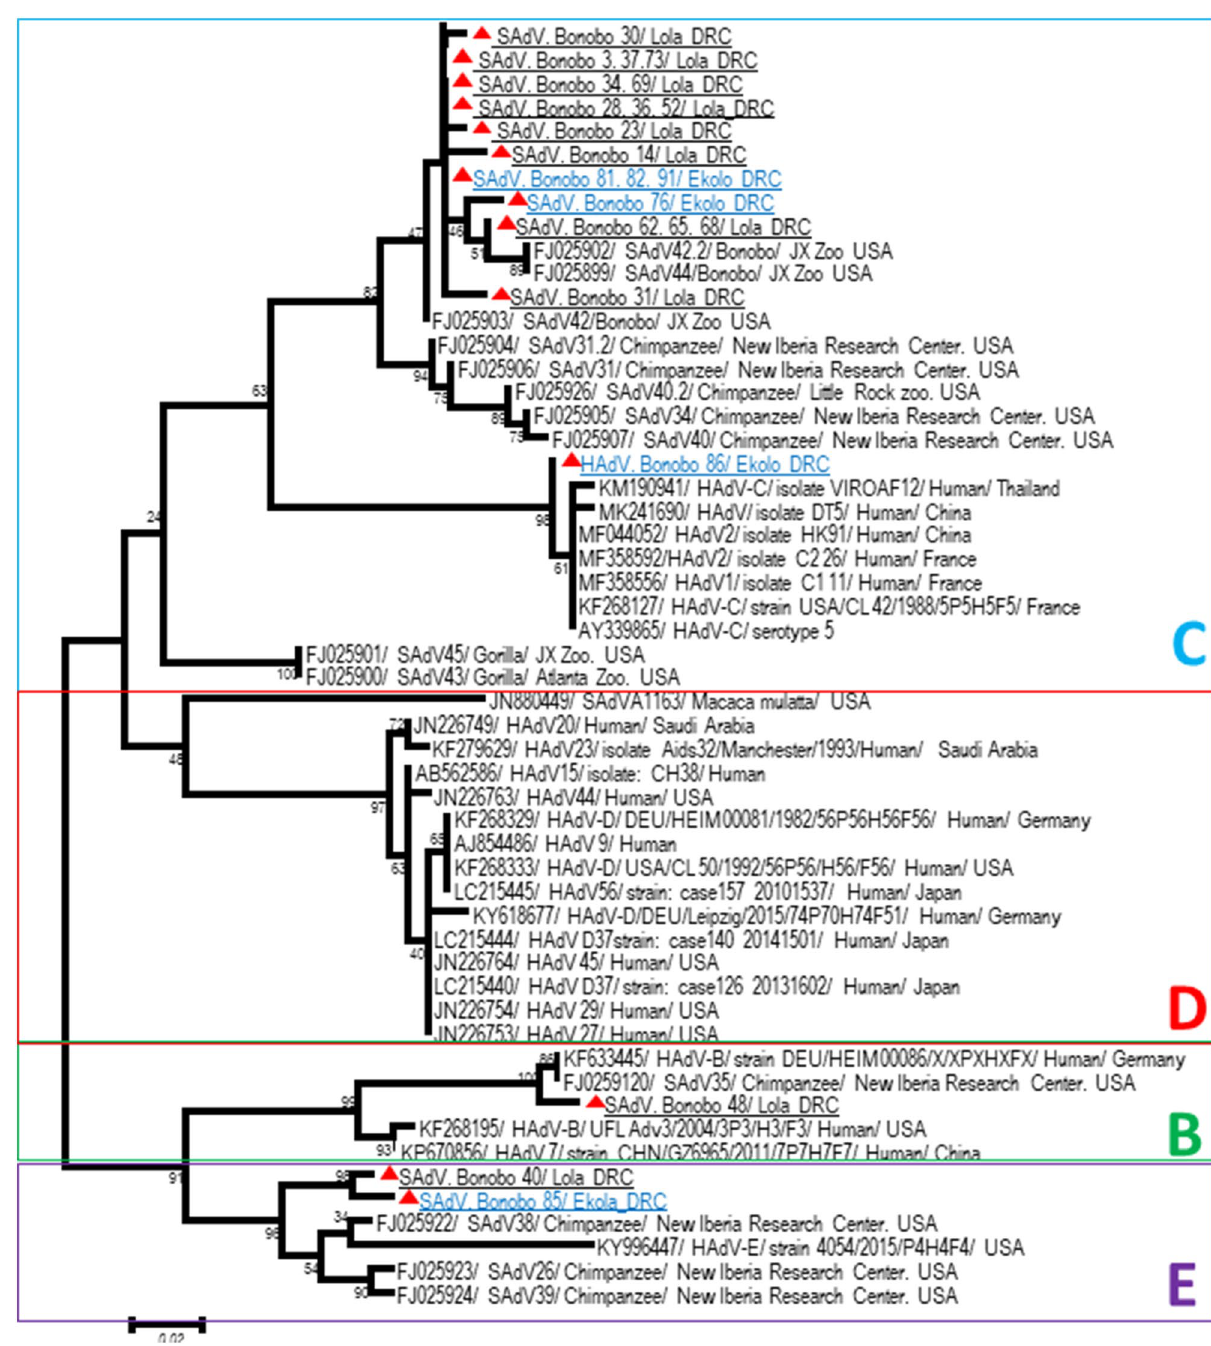
Figure 3. Phylogenetic analysis of Adenoviruses . The evolutionary history, based on 250 bp of DNA PoL gene, was inferred using the Neighbor-Joining method. Adenoviruses obtained sequences here were different in each other and with those available in GenBank database. Sequences are identified as follows: accession number/ virus/strain/host/country.A similarity rate of 92 to 98% was obtained when comparing the obtained sequences from bonobos in Lola to reference strain of Simian adenovirus 42.1 (FJ025903) within HAdV-C species isolated from the gut of bonobo from Jacksonville zoo, USA 23 . Adenovirus strain (Bonobo 86) detected in Ekolo was 93% identity with a Human adenovirus sp. isolate DT5 (MK241690) isolated in a human from China. This suggests a possible “jump” of human strain to bonobos. Other species (HAdV-B and HAdV-E) were detected Lola and/or Ekola bonobos. The differences in the composition bias among sequences were considered in evolutionary comparisons. The analysis involved 39 nucleotide sequences. All positions containing gaps and missing data were eliminated. There were a total of 213 positions in the final dataset. Evolutionary analyses were conducted in MEGA7 61